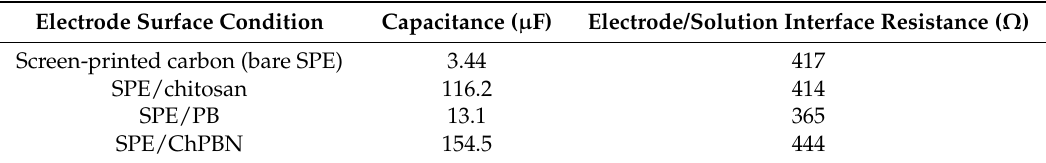
Table 1. Capacitance and interfacial resistance obtained from Nyquist plots in Figure 4c by Boback’s protocol